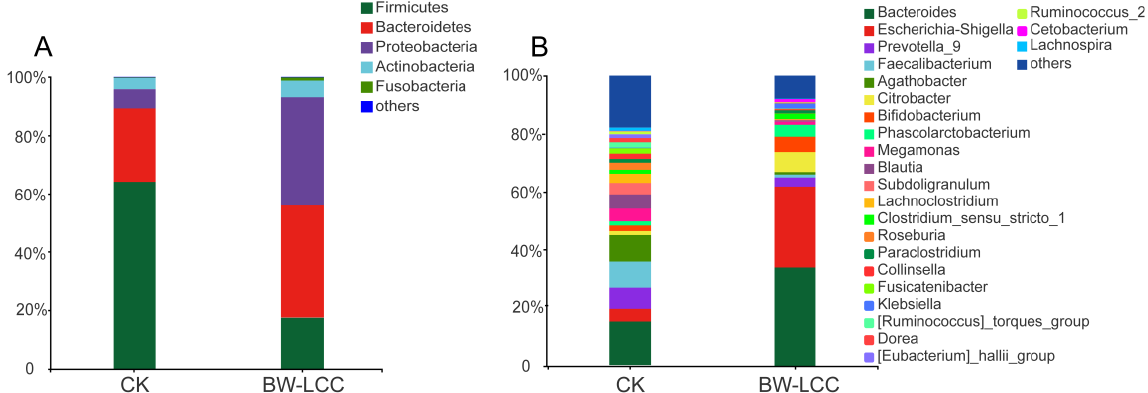
Figure 4. Comparison of microbial community composition between the BW-LCC and CK groups at the phylum ( A ) and genus ( B ) levels.